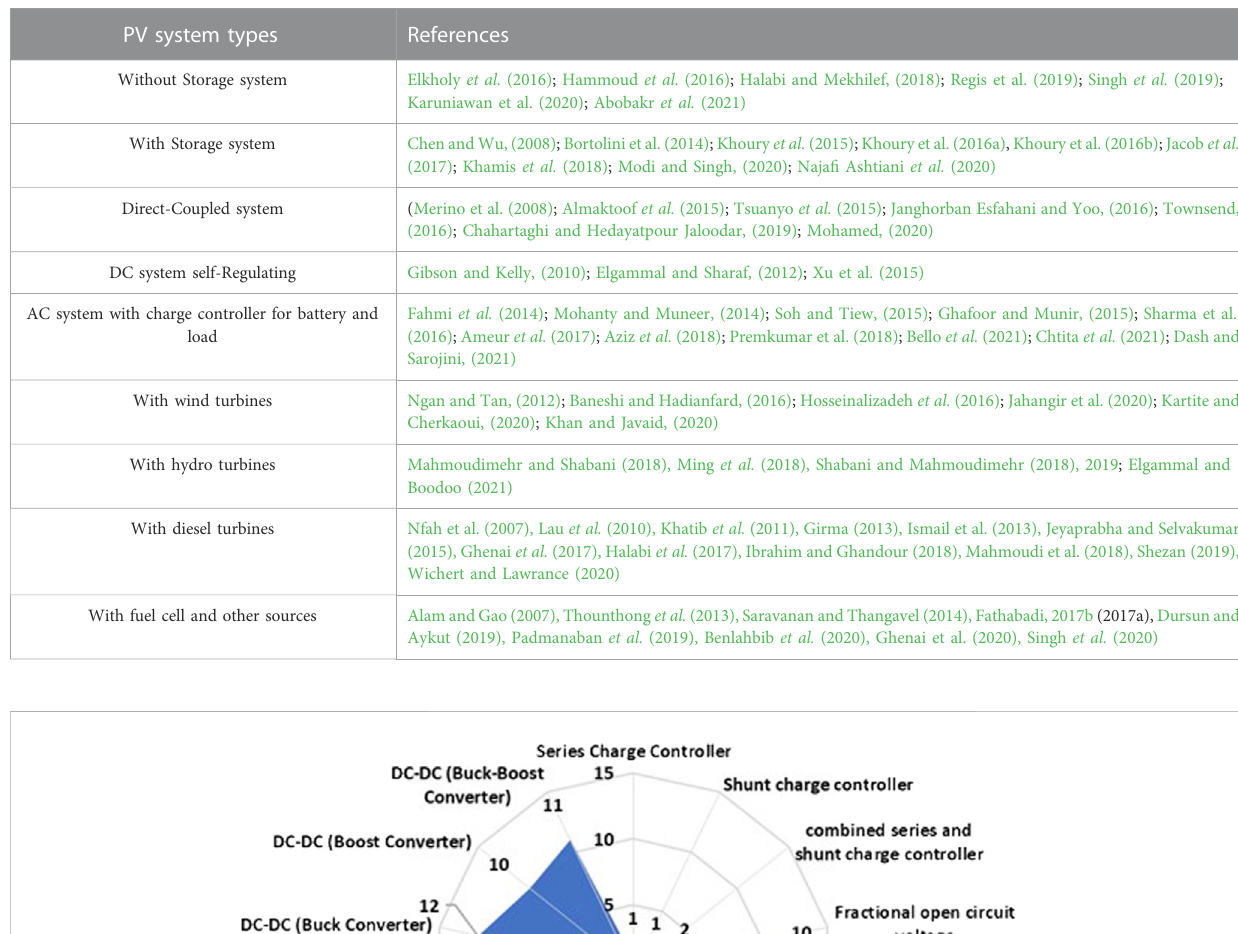
TABLE 2 Compilation study of PV system classi fi cations in the literature. PV system types